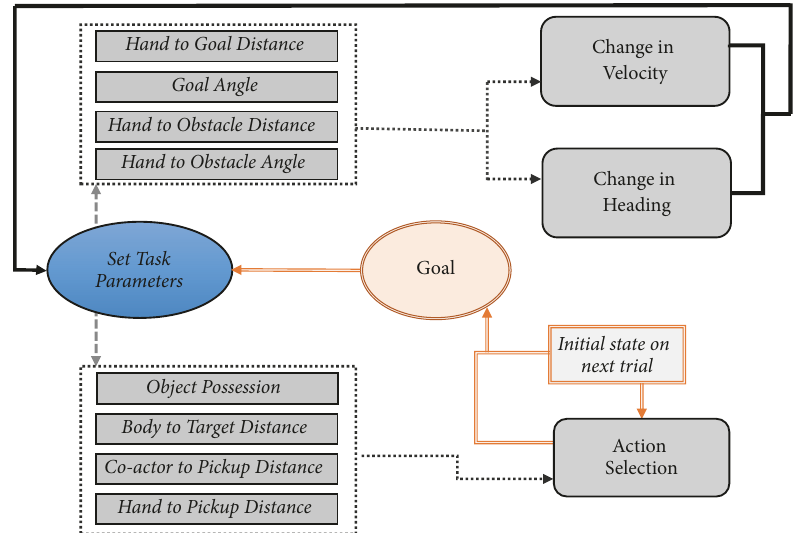
Figure 6: The structure of PAPA [15]. Movement dynamics were calculated in the upper loop and action selection dynamics were calculated in the lower loop. As PAPA moved through the task environment and switched action modes, task parameters were adjusted.